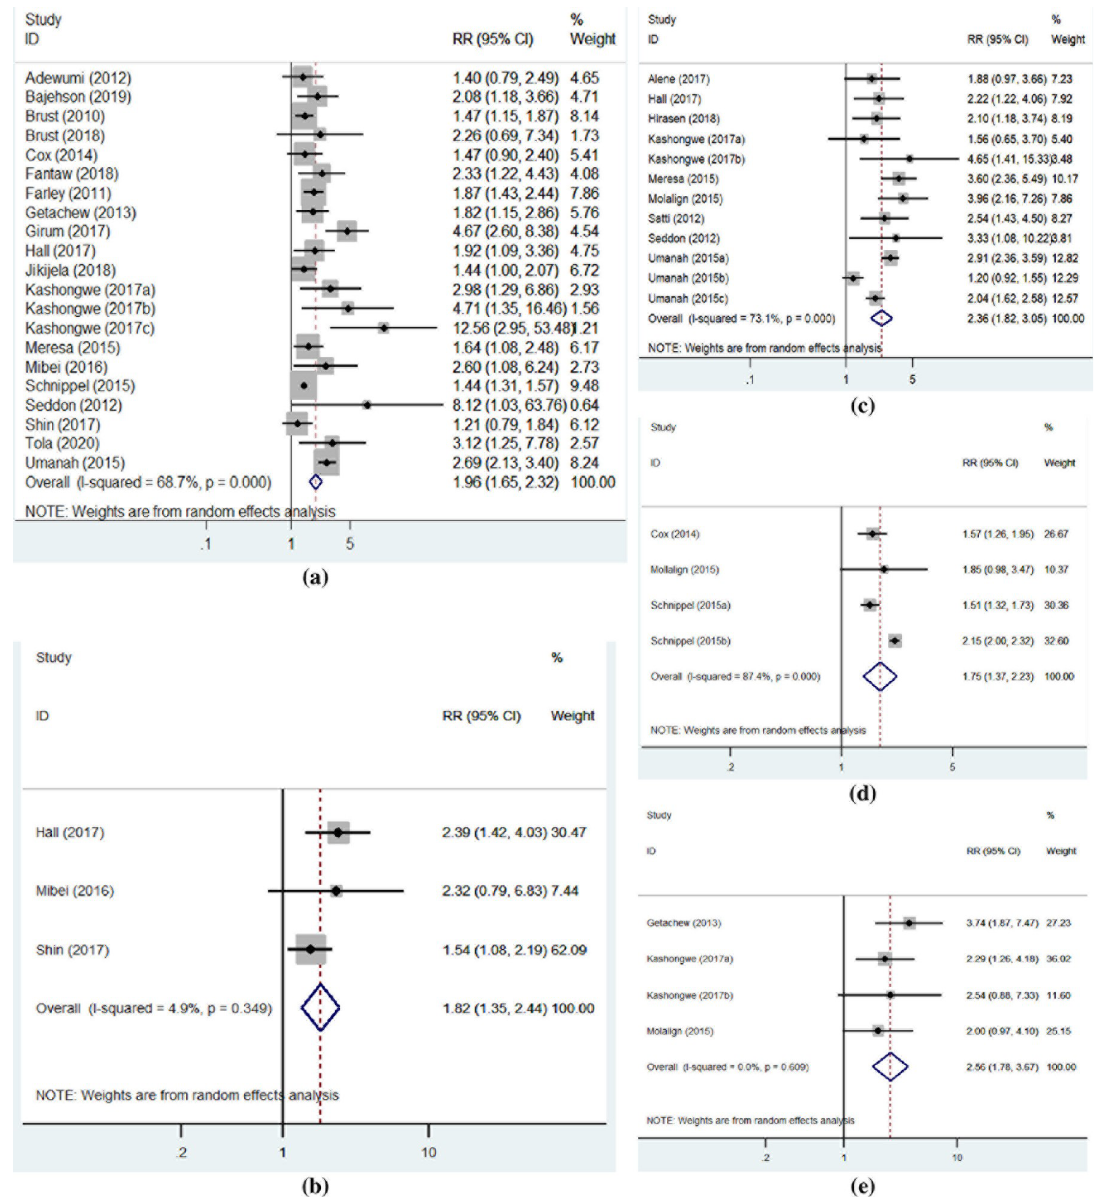
Fig 4. Predictors of mortality among persons receiving SLD in SSA. (a) Forest plot describing presence of HIV and other comorbidities as the predictors of mortality. (b) Forest plot describing male sex as a predictor of mortality. (c) Forest plot describing diagnoses of clinical conditions as the predictors of mortality. (d) Forest plot describing resistance to SLD as a predictor of mortality. (e) Forest plot describing substance uses as the predictors of mortality.